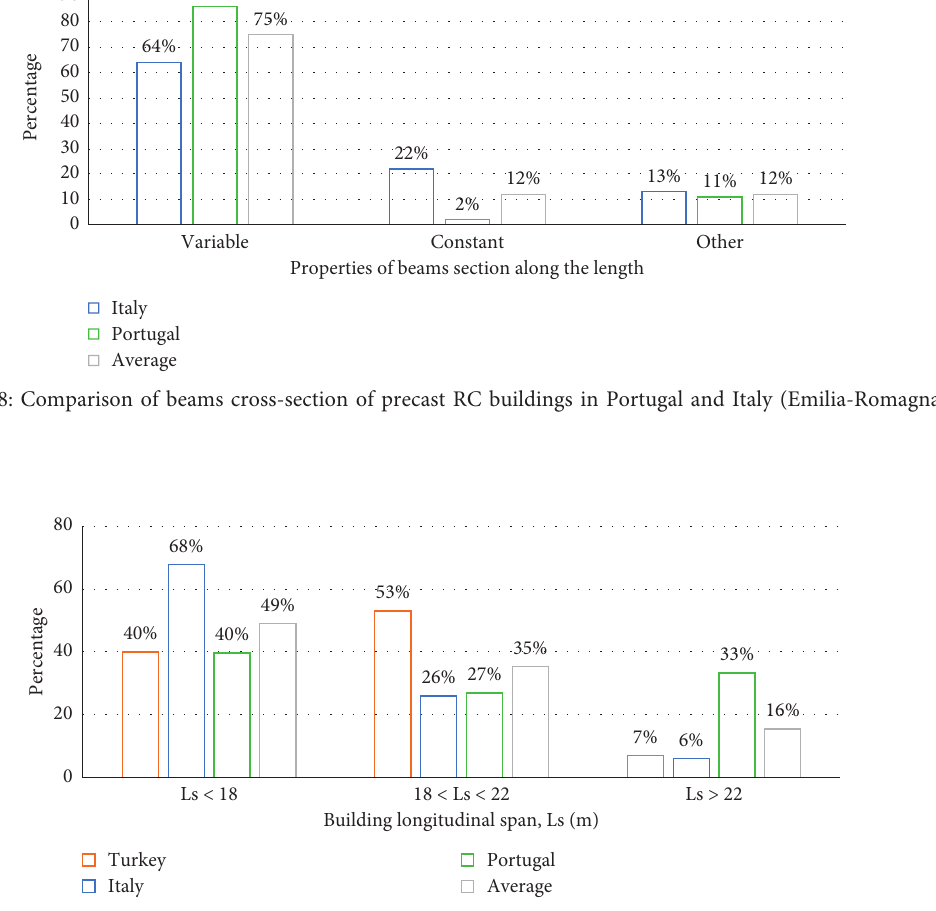
Figure 29: Comparison of longitudinal span (Ls) of precast RC buildings in Portugal, Italy, and Turkey.